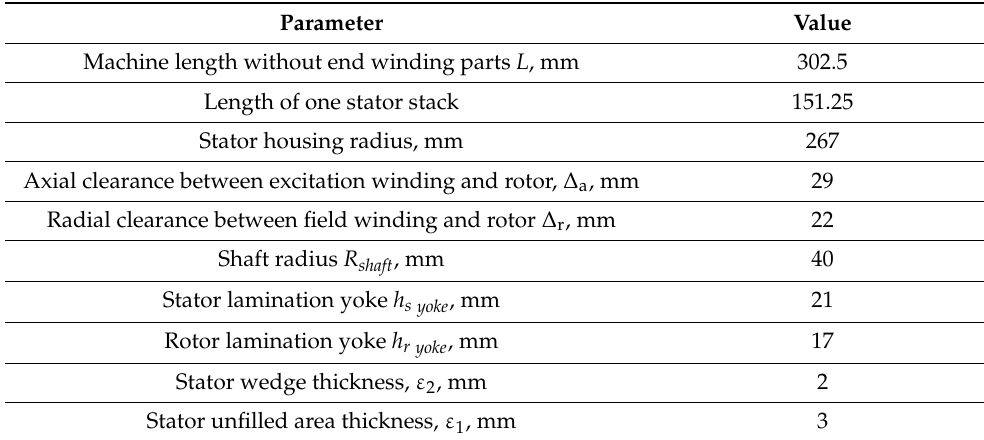
Figure 5. SHMgeometricparameters. ( a )Statorslot; ( b )statorwinding; ( c )rotorcore; ( d )otherdimensions. Figure 5. SHM geometric parameters. ( a ) Stator slot; ( b ) stator winding; ( c ) rotor core; ( d ) other dimensions. Table 2. Some geometric parameters fixed during the